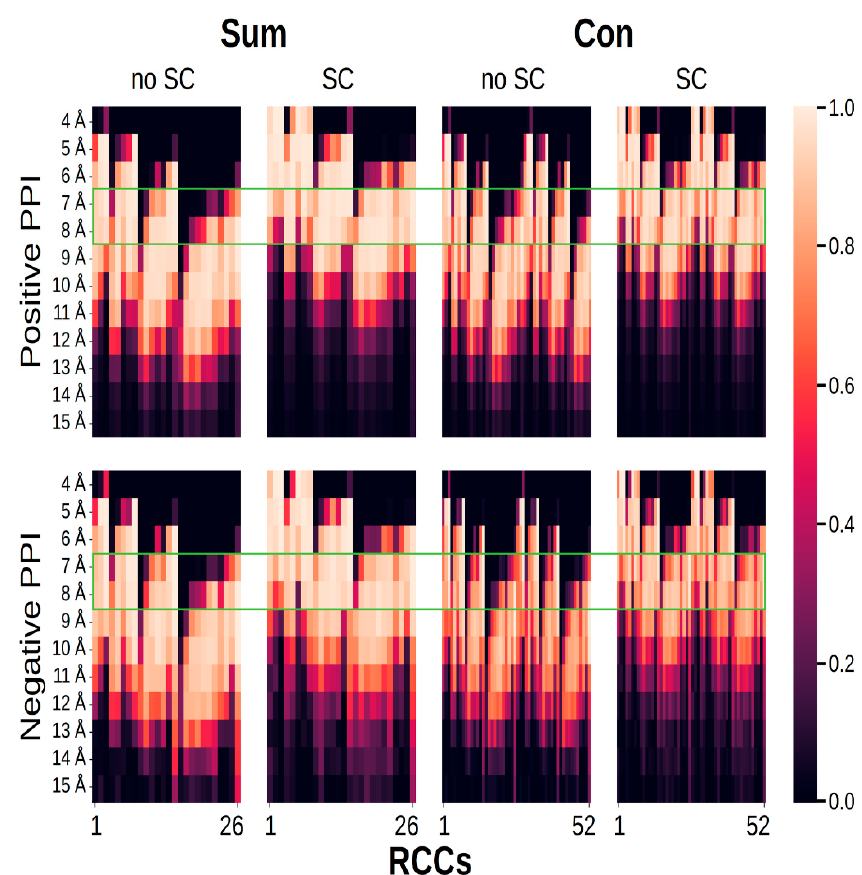
Figure 5. Fraction of RCCs with nonzero values. The graph shows eight different plots presenting the fraction of 26 (sum) or 52 (concatenation) values ( X -axis) used to represent PPI (positive PPI) and pairs of proteins that did not interact (negative PPI); fractions are represented by a gradient color, with lighter colors representing those with more nonzero values. On the Y -axis, the distance used to build the contact map is presented (from 4 to 15 Å). The green rectangle indicates the set of distances used to build RCCs, where the number of features (RCC1, RCC2, RCC3, ... , RCC26) with values equaling zero was